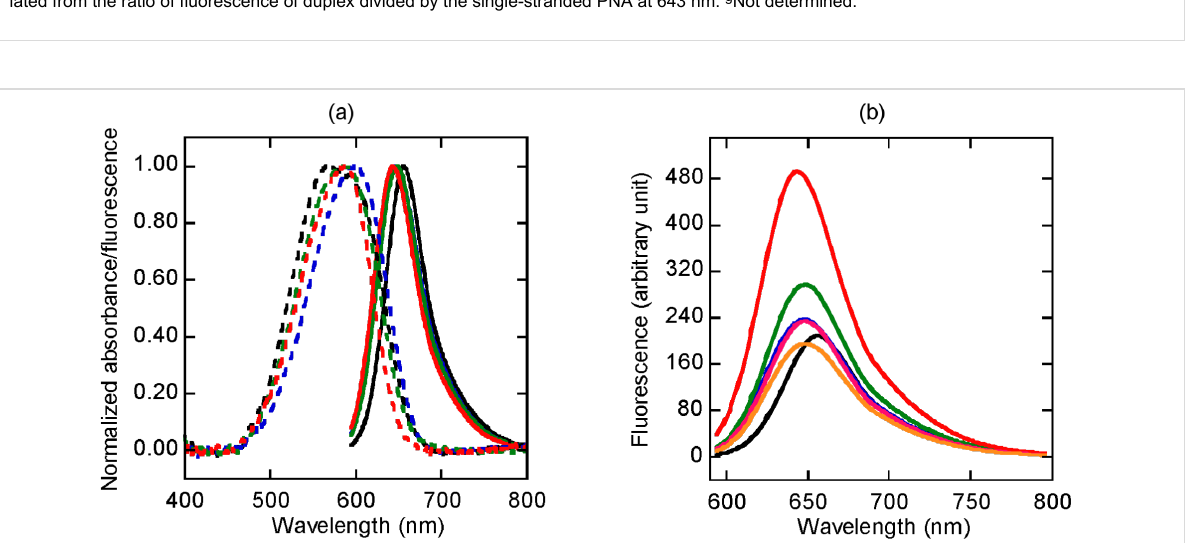
Figure 3: (a) Normalized absorption (---) and fluorescence (––) spectra and (b) fluorescence spectra of Nile red-labeled acpcPNA 10mer-Nr in the absence (black) and presence of various DNA sequences (5’ → 3’): blue = AGTGATCTAC (complementary); green = AGTGCTCTAC (mismatched); red = AGTGA C TCTAC (bulged); pink = AGTGC C TCTAC (bulged with mismatch); orange = AGT C GATCTAC (misplaced bulge). All measurements were carried out in 10 mM sodium phosphate buffer (pH 7.0), [PNA] = 1.0 µM; [DNA] = 1.2 µM at 20 °C with λ ex = 580